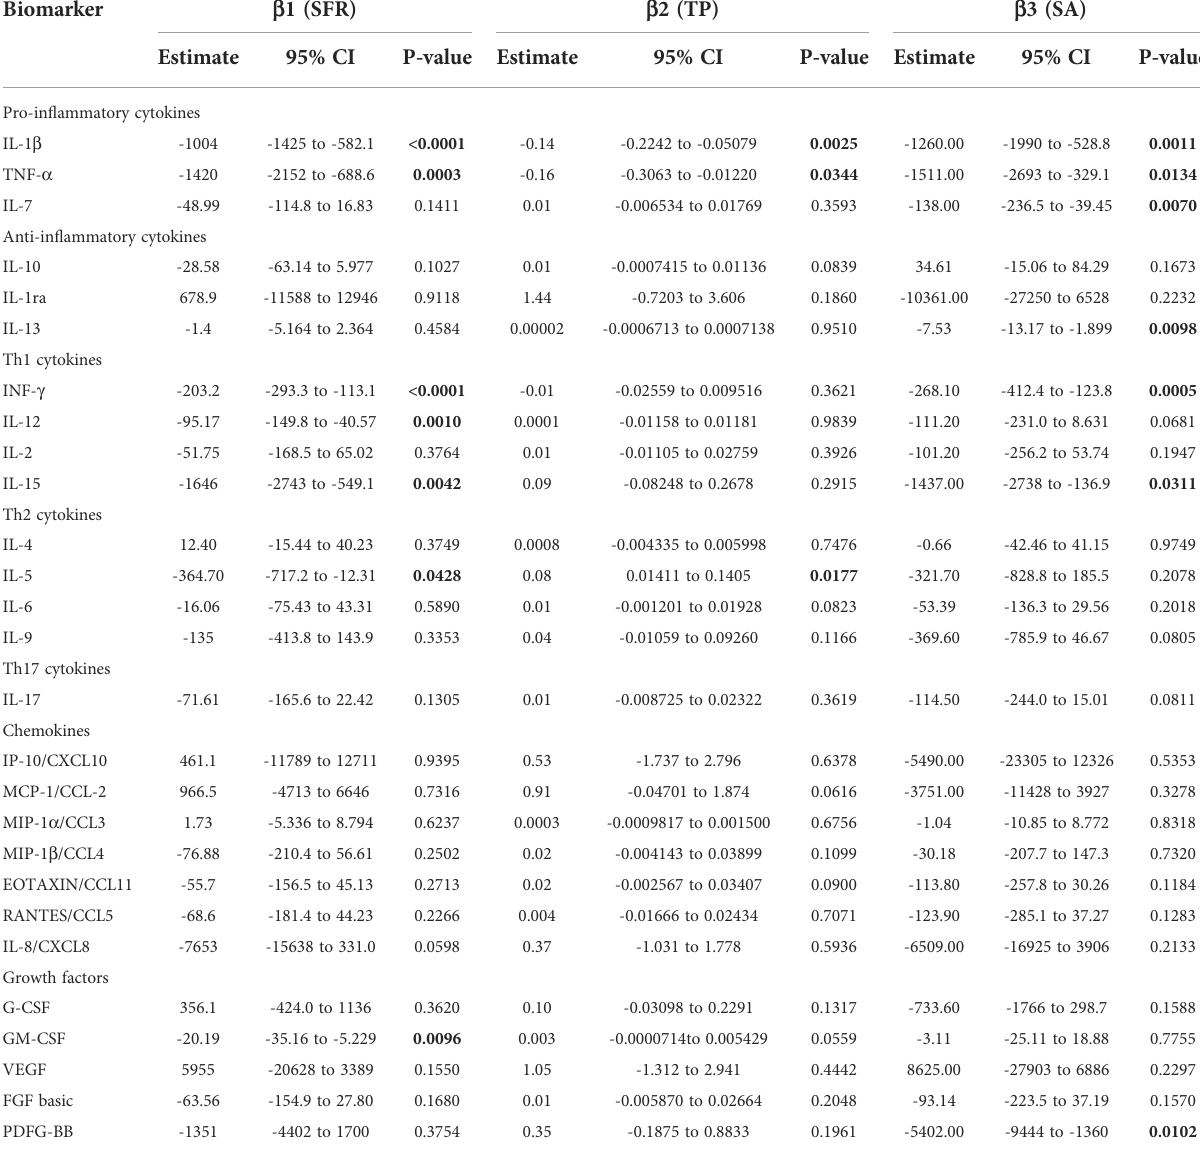
TABLE 4 Multivariate linear regression analysis. Salivary fl ow rate (SFR), total protein (TP) and salivary amylase (SA) were used as independent variables.